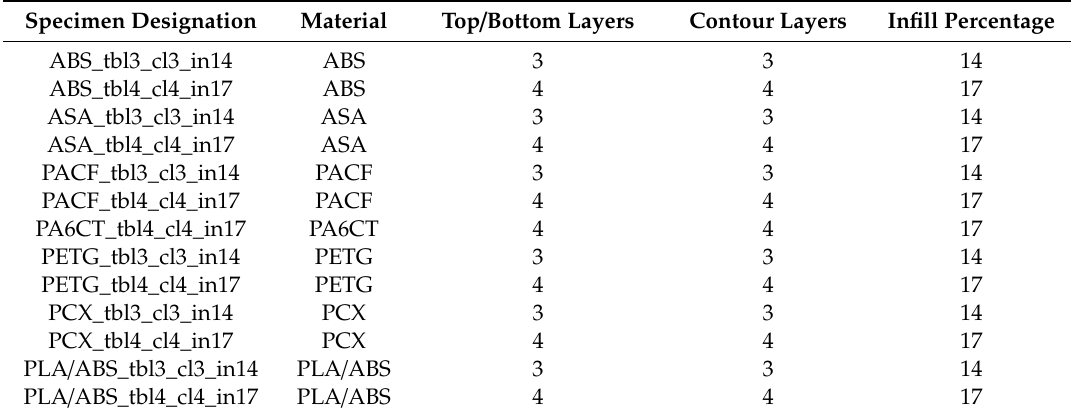
Table 1. Variation parameters test series 1 (infill rectangular).